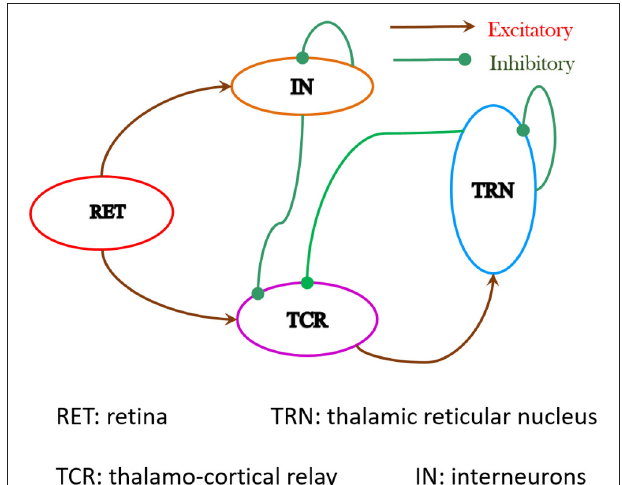
FIGURE 1 | The synaptic layout of the model is based on experimental data obtained from the dorsal Lateral Geniculate Nucleus (LGNd) of mammals and rodents. Both TCR and IN cells of the LGN receive excitatory inputs from the retinal spiking neurons. The IN cells make inhibitory synapses on themselves as well as on the TCR cells. Information on the synaptic pathway from the TCR to IN is ambiguous in literature and is ignored here. The TCR cells make excitatory synapses on the TRN cells. The TRN cells makes inhibitory synapse on the TCR cells as well as on themselves. The synaptic connectivities in the network are sparse and the probabilities of connectivity p conn between pre-synaptic and post-synaptic populations in the model are mentioned in Table 1